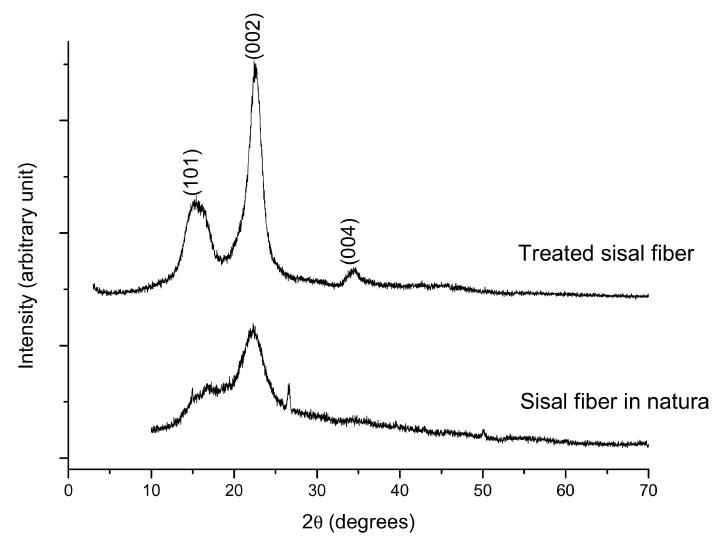
Figure 4. Diffractograms of the sisal